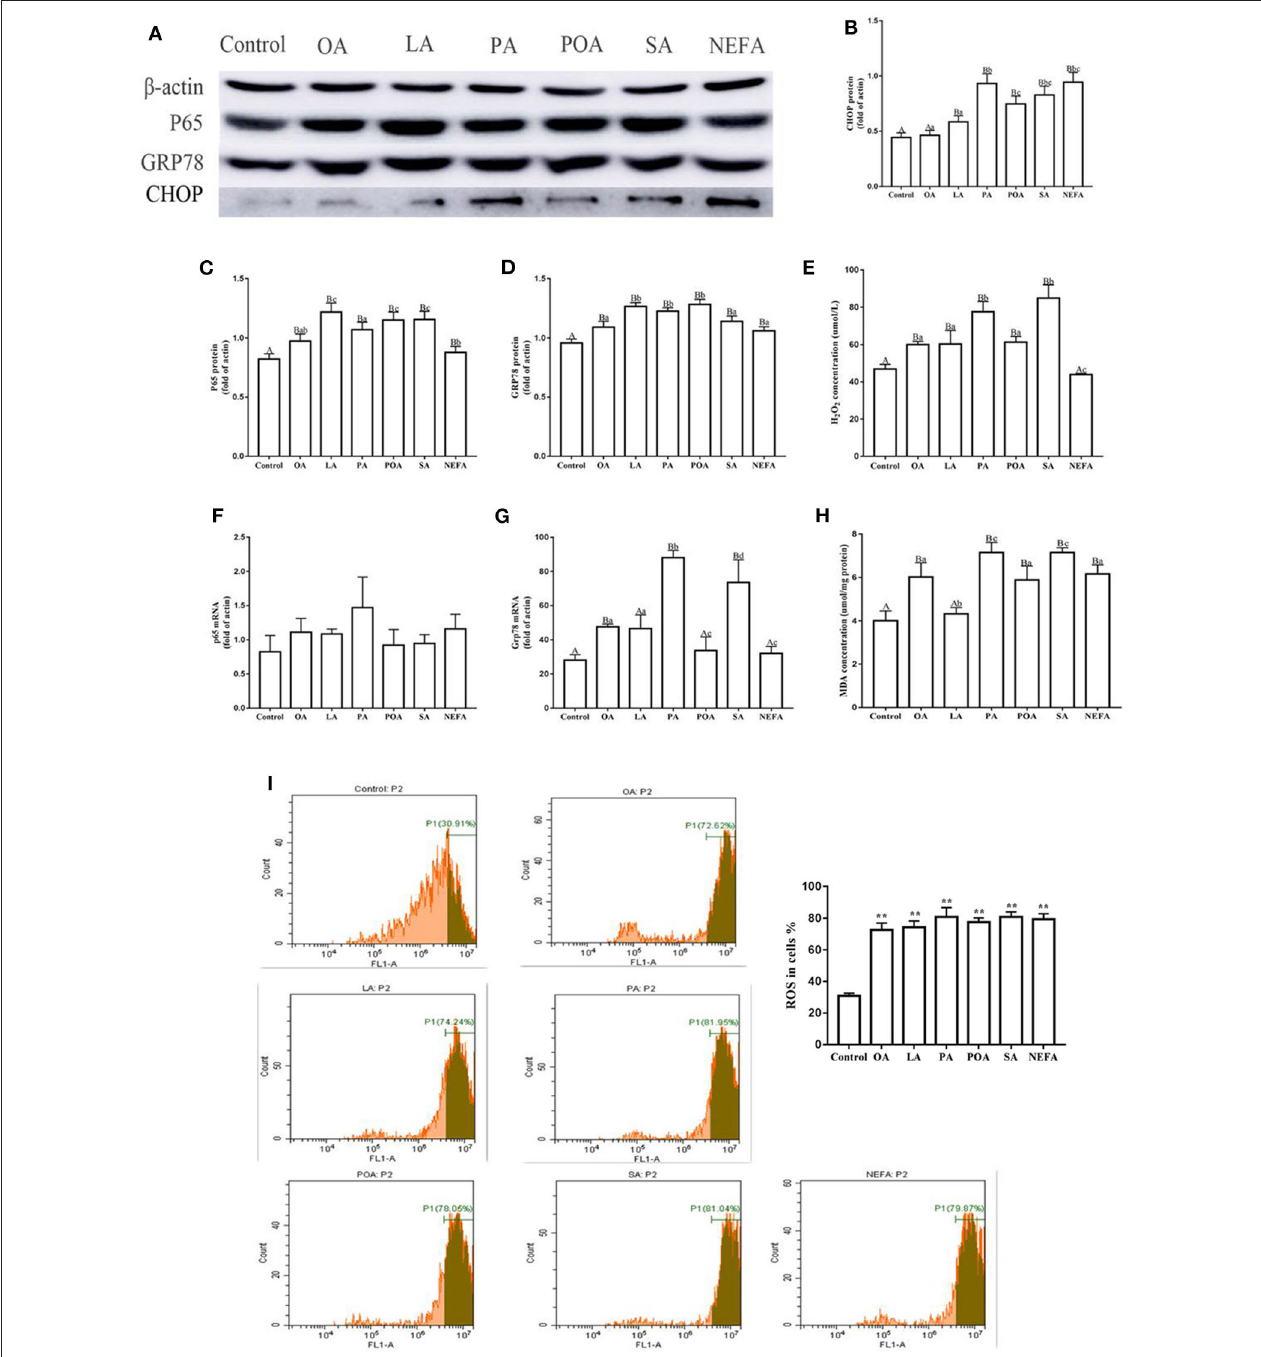
FIGURE 1 | Effects of different fatty acids on stress and inflammatory response of primary hepatocytes. Cells were treated with 1.2 m M fatty acids for 12h ( n = 3 ell preparations). (A) β -actin, P65, GRP78, and CHOP protein expression were assayed by western blotting. Gray-shaded bars represent the amount (%) of β -actin, P65, GRP78, and CHOP in primary hepatocytes. (B–D) CHOP, P65, and GRP78 protein expression in primary hepatocytes were assayed by western blotting and reported relative to β -actin. (F,G) P65 and GRP78 mRNA expression were assayed by real-time RT-qPCR. (I) ROS were assayed by fluorescence microscopy and flow cytometry. Fluorescence intensity is proportional to ROS activity in primary hepatocytes. ** p < 0.01 solvent and control group. (E,H) H 2 O 2 ( µ mol/L) and MDA ( µ mol/mg protein) were assayed using commercial kits. Four assays were independently performed in each group. Uppercase letter vs. control p ≤ 0.05, lowercase letter vs. fatty acid group p ≤ 0.05, the same letter vs. no letter mark p ≥ 0.05.